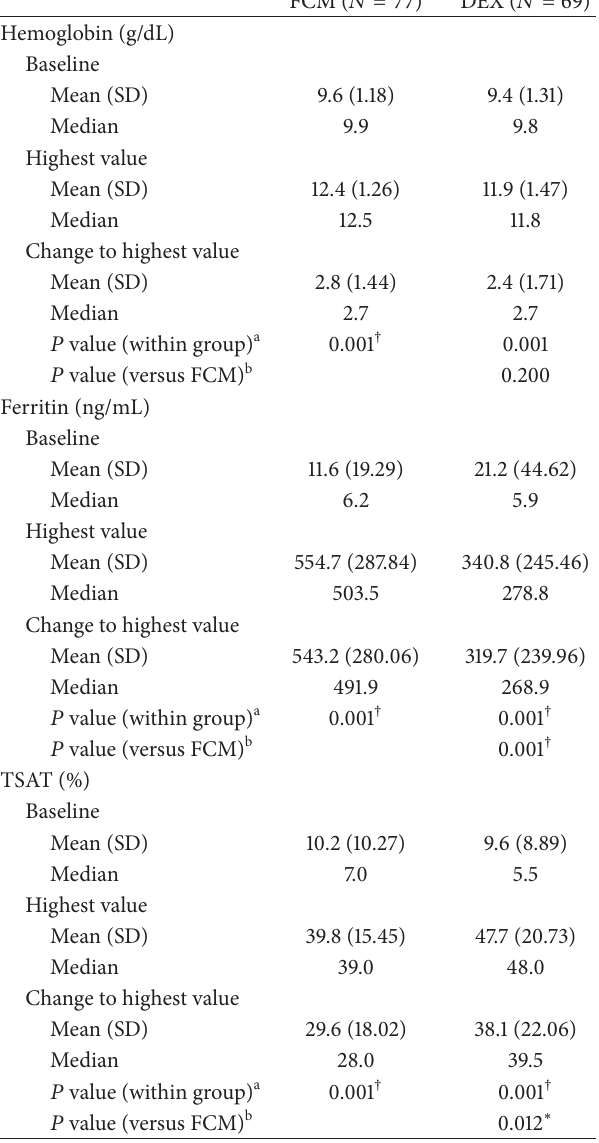
Table 6: Changes in hemoglobin, ferritin, and TSAT values.